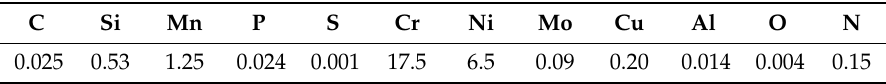
Table 1. Chemical composition (wt.%) of the steel studied. The balance is